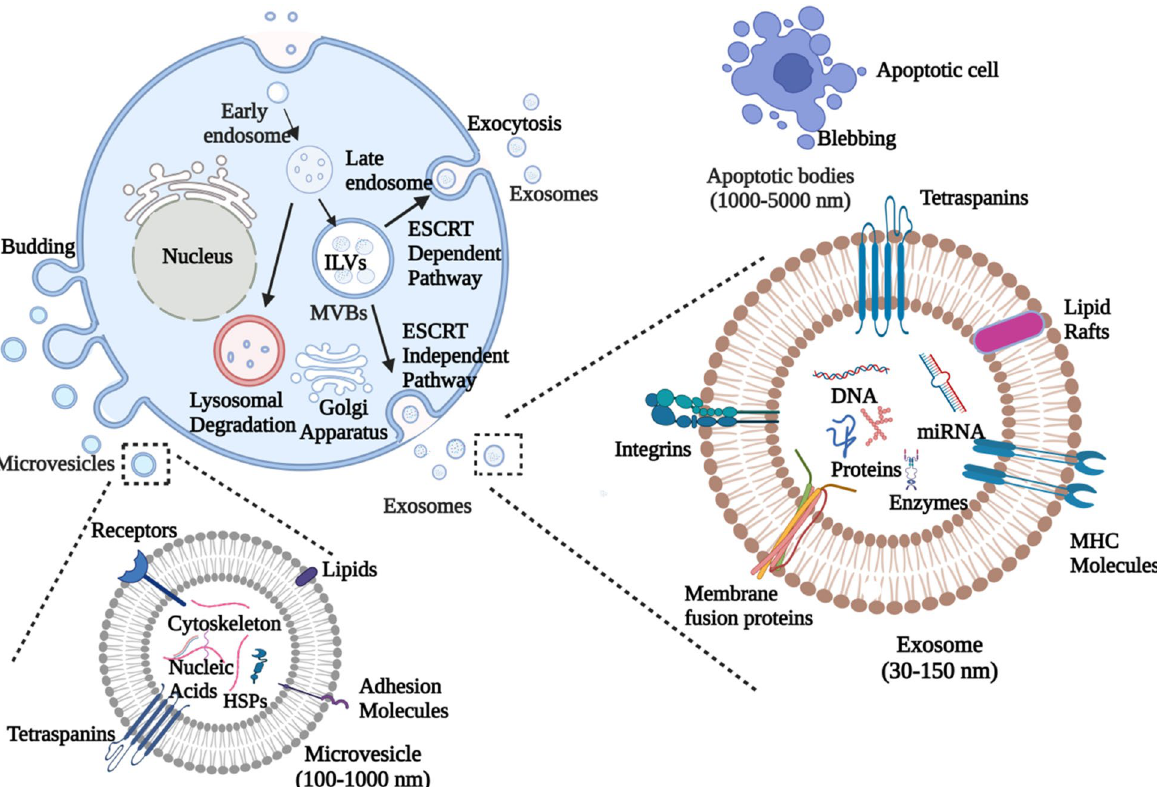
Fig. 1 Biogenesis of extracellular vesicles. Exosomes are generated by budding of early endosomes into intraluminal vesicles (ILVs) that are released upon fusion of multivesicular bodies (MVBs) with plasma membrane. MVBs usually have one of two destinies either lysosomal degradation or their release on fusion with plasma membrane, allowing their contents to be released into the extracellular environment. This release can be either ESCRT dependent or ESCRT independent. Microvesicles are generated by outward budding of the plasma membrane into the extracellular region. Apoptotic bodies are formed by the blebbing of plasma membrane from apoptotic